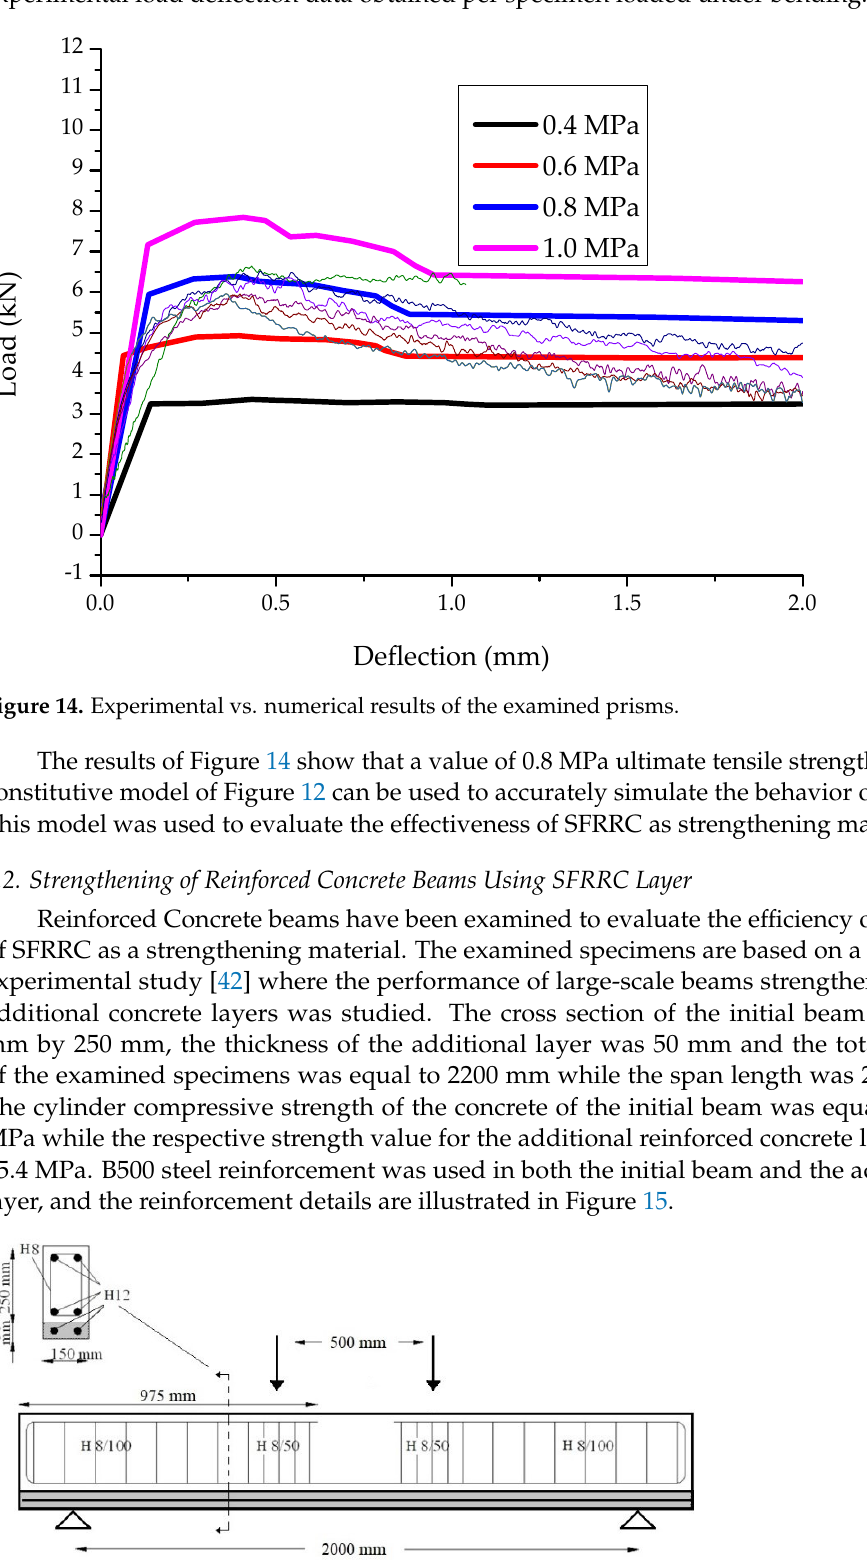
Figure 15. Geometry and reinforcement details of the strengthened beams. Adapted from [42].